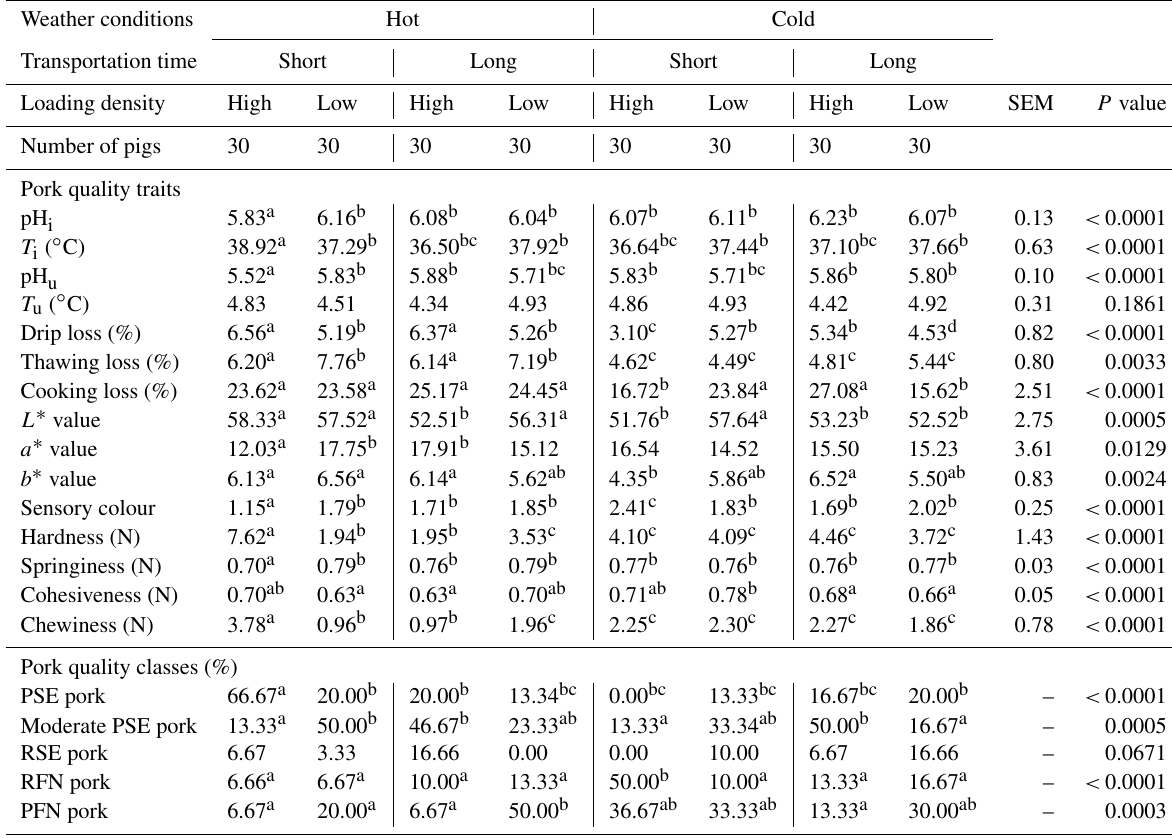
Table 2. The combined effects of weather conditions, transportation time and loading density on pork quality traits ( n = 240). Weather conditions